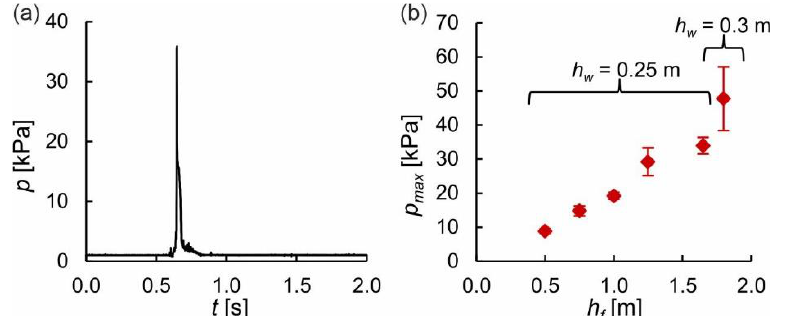
Figure 3. ( a ) Typical signal (pressure p over time t ) of a wave impact simulation from tests with a pressure load cell in the impact zone (fall height h f = 1.65 m and water level in the pipe h w = 0.25 m). ( b ) Maximum impact pressures p max measured for different fall heights h f and water levels in the pipe h w . Error indicators showing the standard deviation.